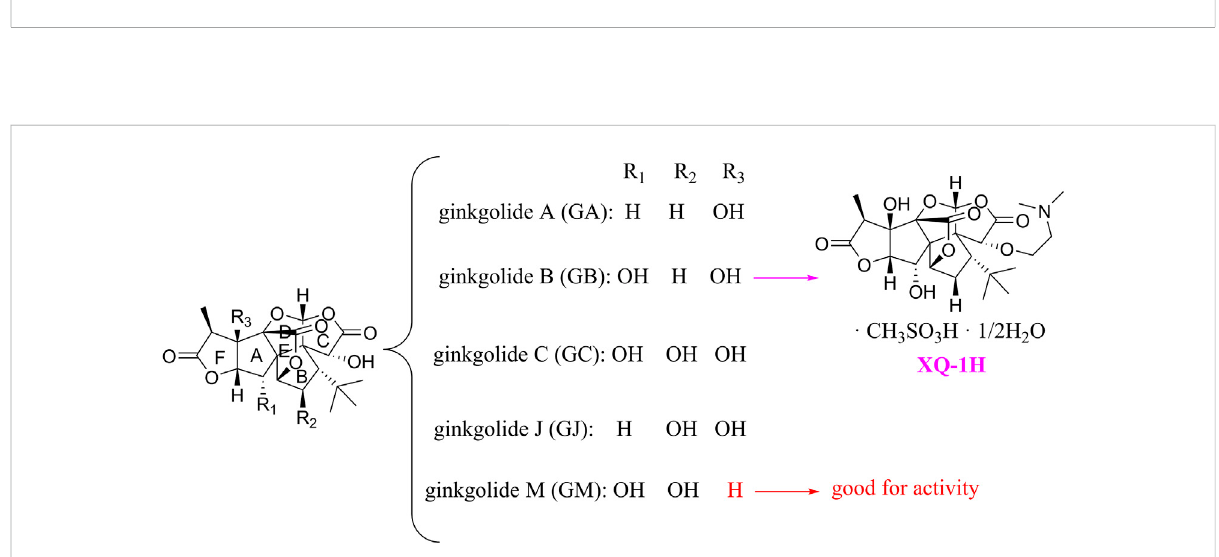
FIGURE 6 Ginkgolides and their derivatives.